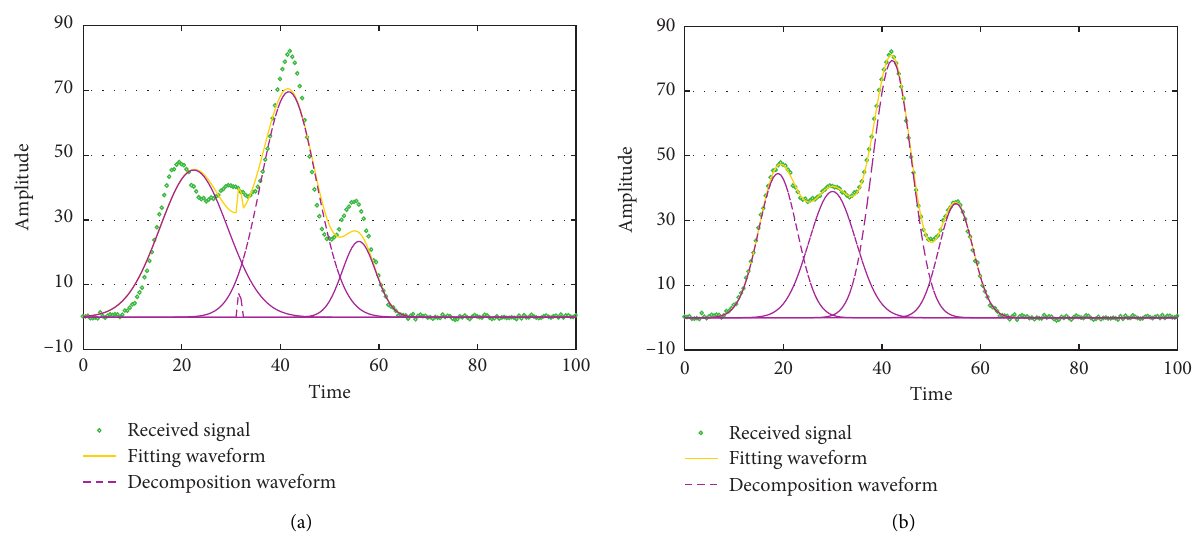
Figure 2: Decomposed waveforms obtained for the two optimization methods (a) without and (b) with parameter separation for group